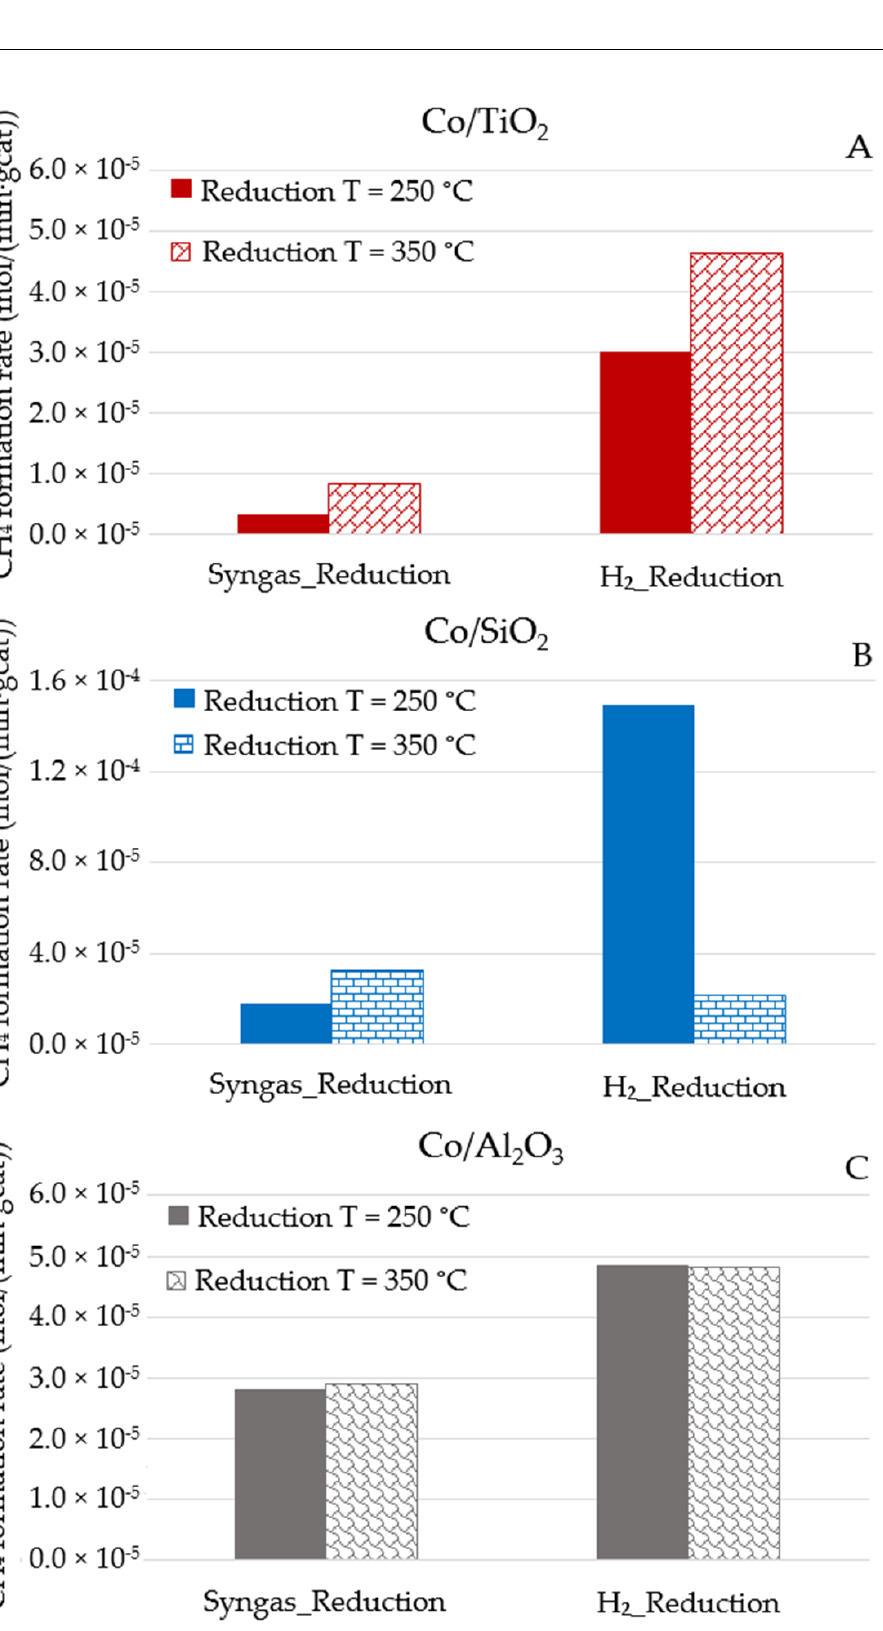
Figure 5. CH 4 formation rate as a function of reducing agent and temperature: ( A ) for Co/TiO 2 , ( B ) for Co/SiO 2 , and ( C ) for Co/Al 2 O 3 . Reaction conditions: 20 bar, 60 mL/min, and 210 ° C.